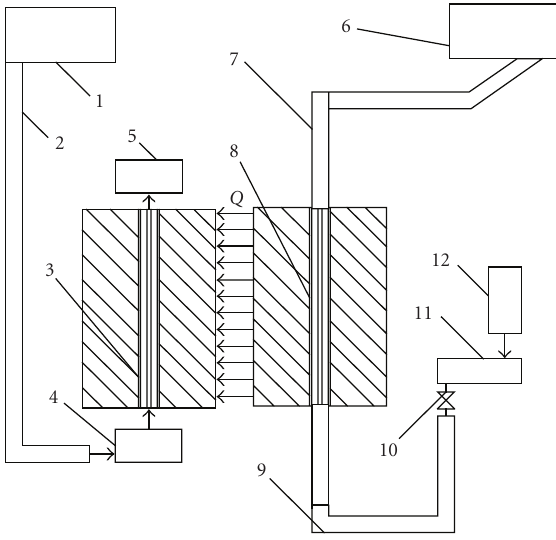
Figure 3: Simplified model of Ignalina NPP for thermal-hydraulic analysis of processes in RCS (for RELAP5-3D code): (1) water tank of AHS, (2) pipeline, (3) CPS channel, (4) bottom distribution header, (5) top distribution header, (6) model of DS and steam lines, (7) steam-water pipeline, (8) eight fuel channels, (9) bottom water pipeline, (10) individual control valve, (11) GDH, (12) water supply from MCP pressure